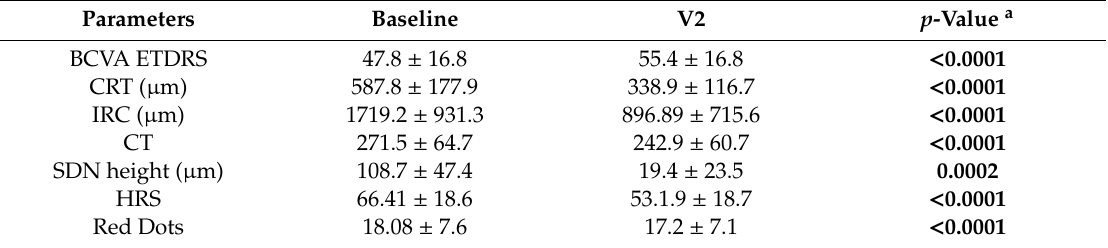
Table 3. Comparison between baseline and post-treatment (V2) data in the Dexamethasone group.